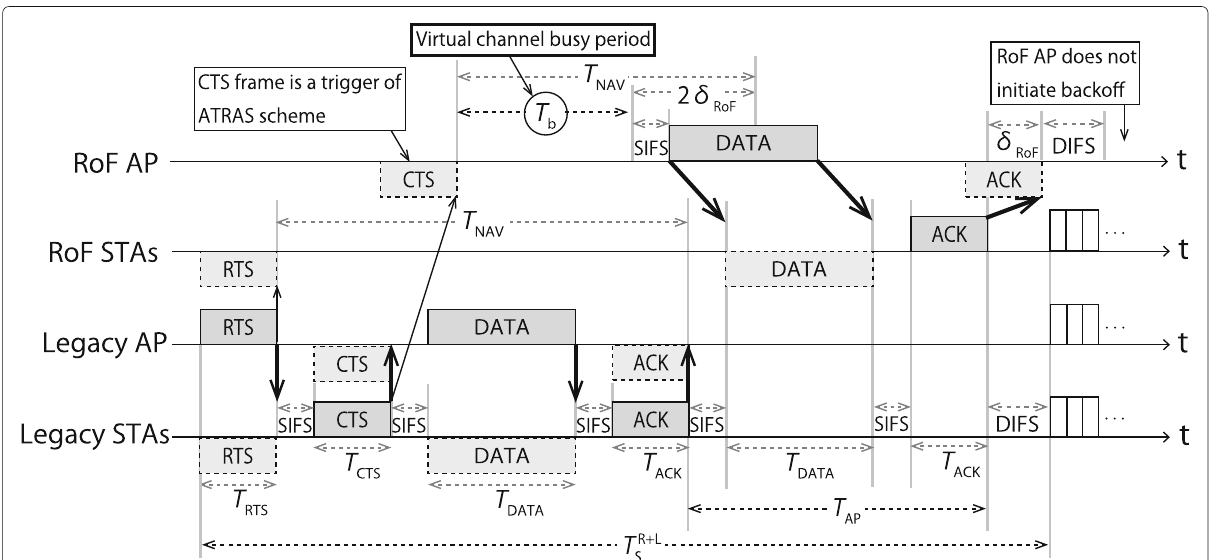
Fig. 6 Transmission procedure of ATRAS scheme when RTS/CTS is used in legacy WLANs. The frame transmission of the RoF AP is triggered by CTS frame transmitted by a legacy